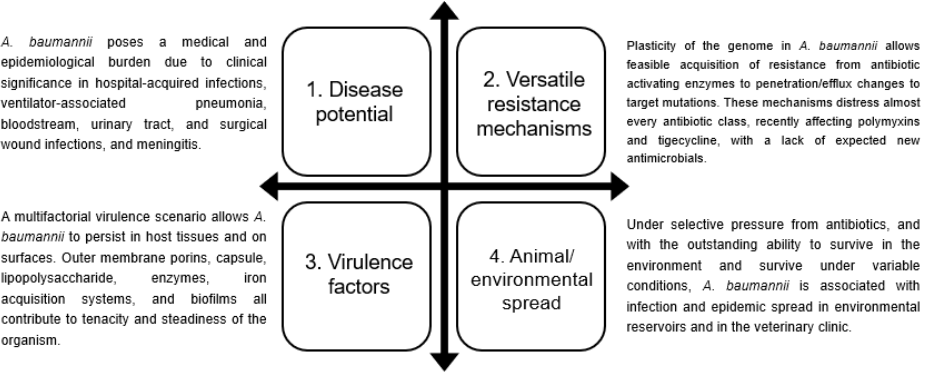
Figure 1. The dynamic microbiological nature of Acinetobacter baumannii derives from an interplay between the associated infections, wide arsenal of virulence factors, multidrug-resistant phenotype, and spread in animals and the environment.